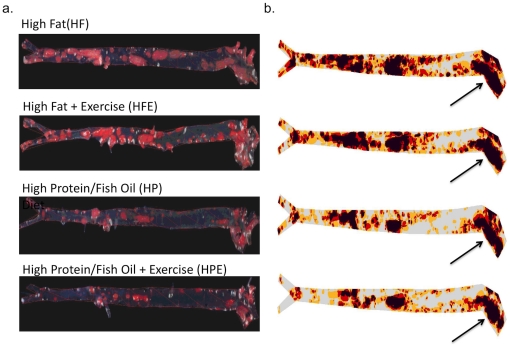
Comparisons of atherosclerotic plaque accumulation between groups.Aortas were harvested at the time of sacrifice (8-months), fixed in paraformaldehyde and stained with Oil-Red as described in Methods. Left panels show light microscope view of aortas representative of each condition. Right panels show subtraction images used for plaque quantification by densitometry (the method is described in detail in Ref 49).